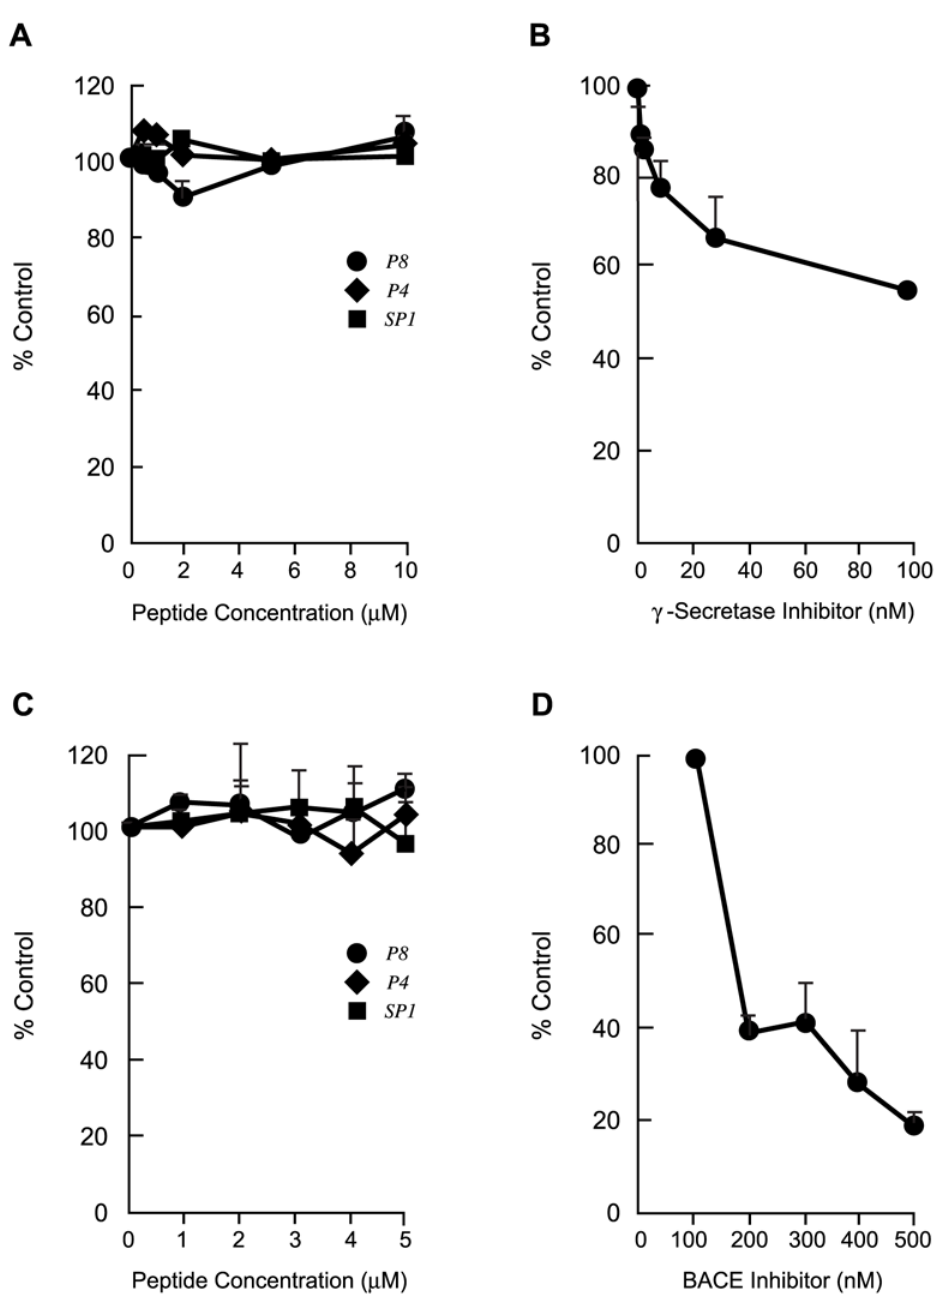
Fig 8. Dose-dependent Effects Of Peptides P4, P8 and Scrambled P1 On NICD Levels And on BACE-1 Activity In Vitro . A. NICD levels in extracts of Jurkat cells that had been treated with 0 – 10 μ M P4, P8 and SP1 for 24 h determined by ELISA. Absorbance was monitored a 450nm and data are expressed as means ± s.e.m. of percent control without peptide. N = 2 – 3. B. NICD levels in extracts of Jurkat cells that had been treated with the γ -secretase inhibitor Semagacestat LY450139 for 24 h. Data are expressed as in A, n = 2. C. BACE-1 activity in extracts of IMR-32 cells that were treated with 0 – 5 μ M P4, P8 and SP1 for 24h, determined with the SensiZyme BACE-1 activity assay kit. Absorbance was monitored at 405 nm and data are expressed as means ± s.e.m. of percent control (without peptide) BACE activity. N = 2 – 3. D. BACE-1 activity in extracts of IMR-32 cells that were treated with the BACE inhibitor LY281137 (0 – 500 nM) for 24 h, expressed as in C. N =